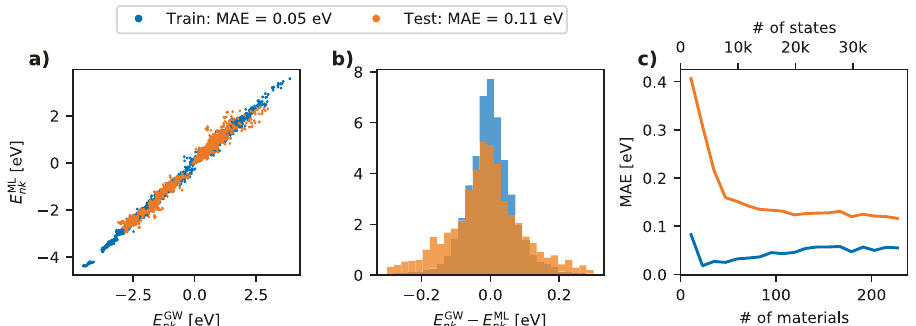
Fig. 4 Machine learning results. a Parity plot showing the ML predicted vs. true values of the GW correction for individual states for the train and test set. The MAEs of the train and test set are 0.05 and 0.11 eV, respectively. b Histograms of the prediction residuals of the train and test set. c Learning curve for the ML model showing validation MAE as a function of the number of materials/states in the